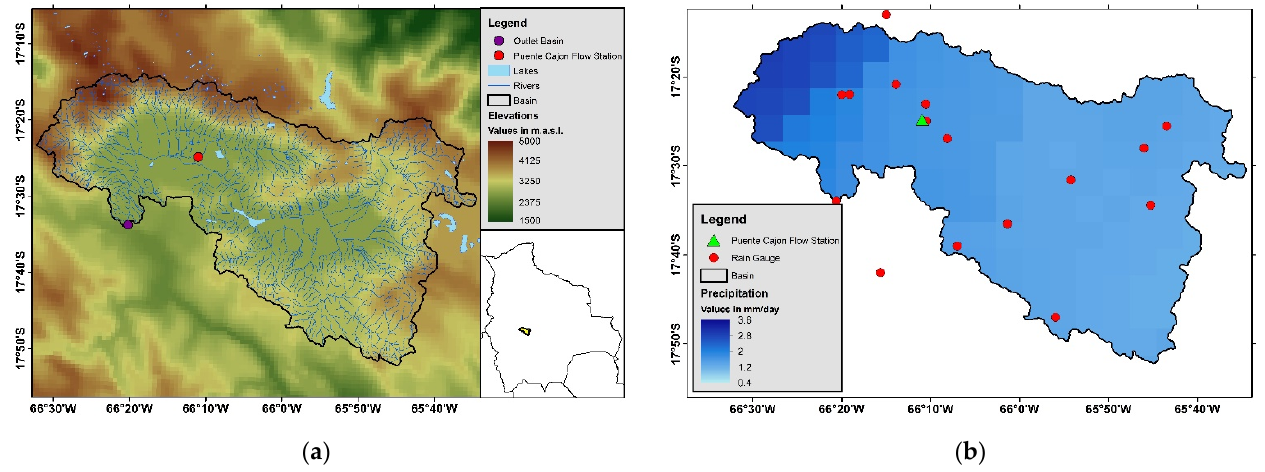
Figure 13. ( a ) Rocha basin elevation map point and ( b ) average daily precipitation map for the period 2000–2015, with the Puente Cajón flow measuring station shown as a green triangle.